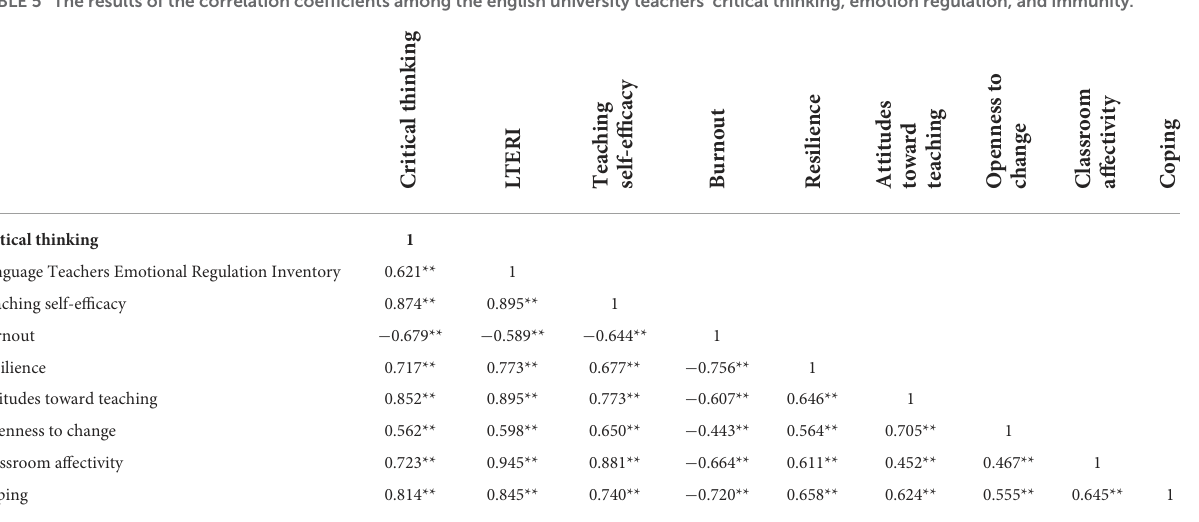
TABLE 5 The results of the correlation coefficients among the english university teachers’ critical thinking, emotion regulation, and